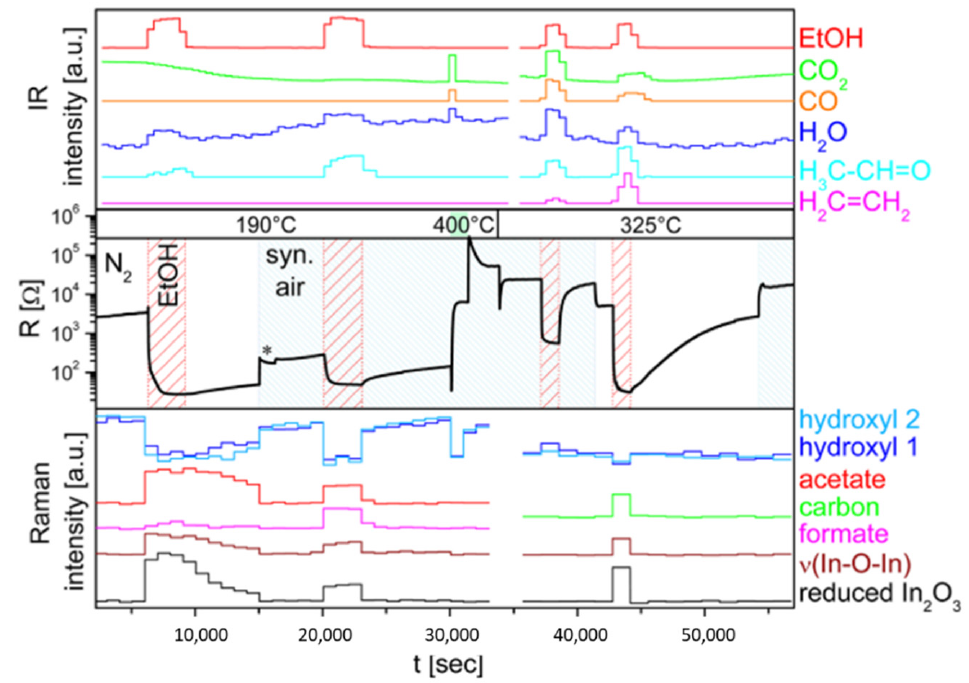
Figure 4. Correlative in-operando FTIR and Raman spectroscopy signals with sample resistance during ethanol exposure of indium oxide sensors. Adapted with permission from [21]. Copyright 2014, American Chemical Society.